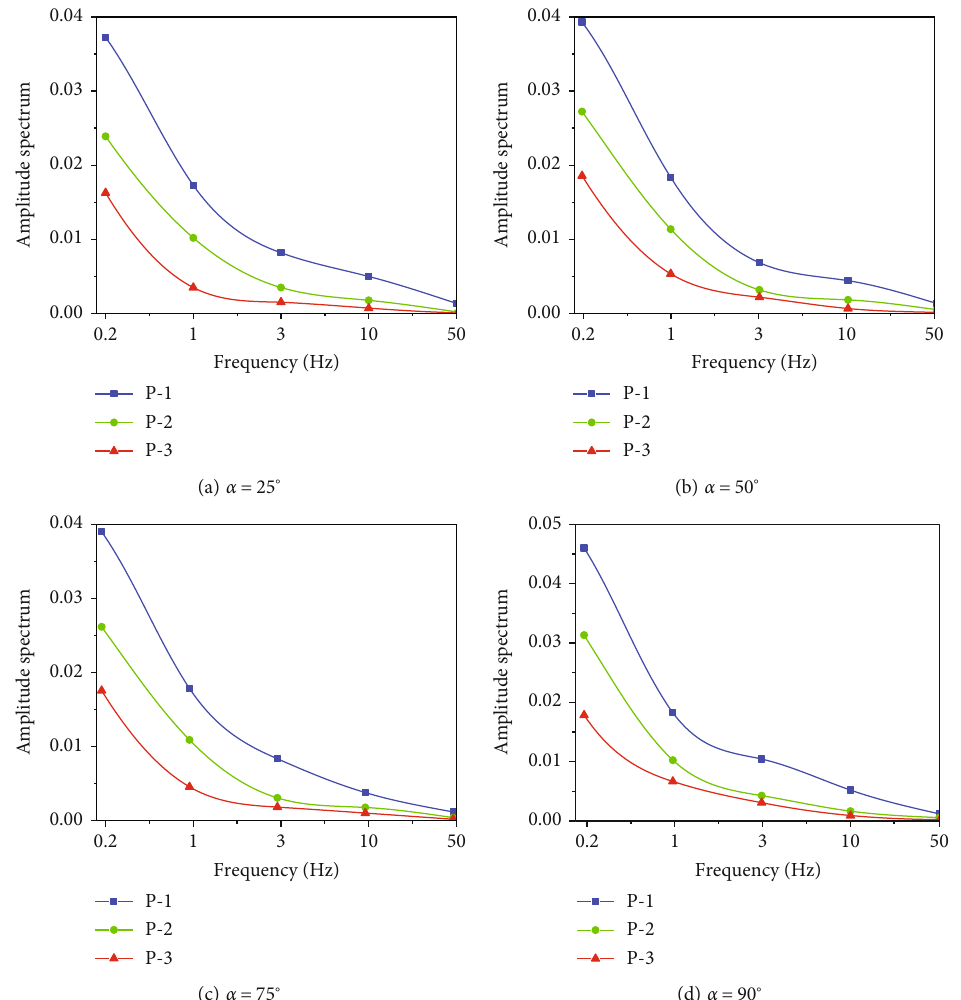
Figure 14: Frequency-spectrum evolution under di ff erent joint